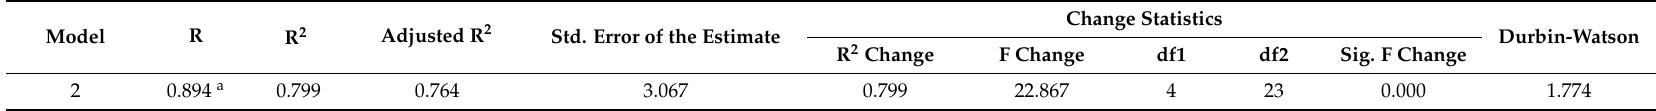
Table 18. Model Summary for Heraklion b